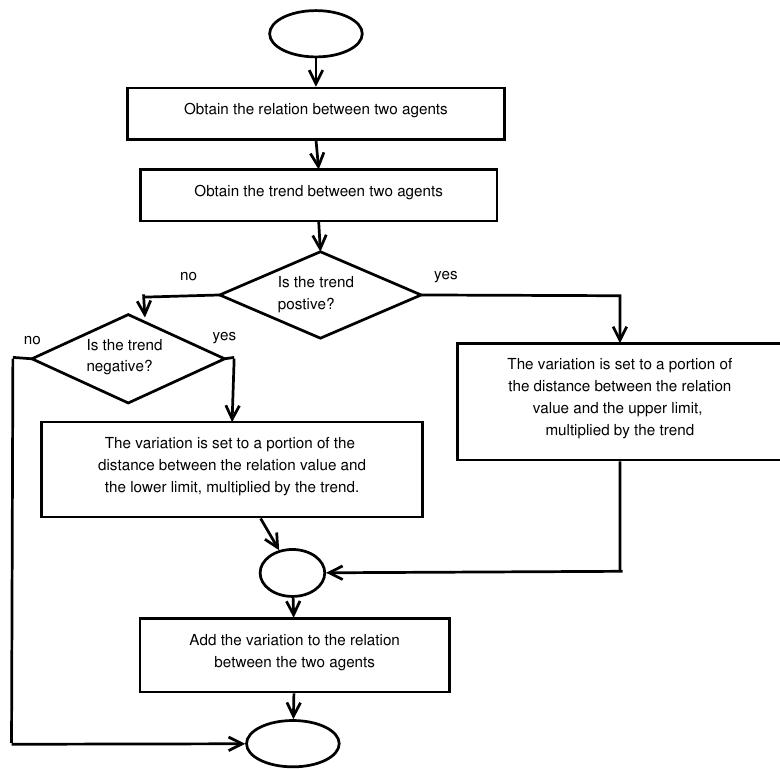
Figure 7. Dataflow diagram for updating the relationships according to their